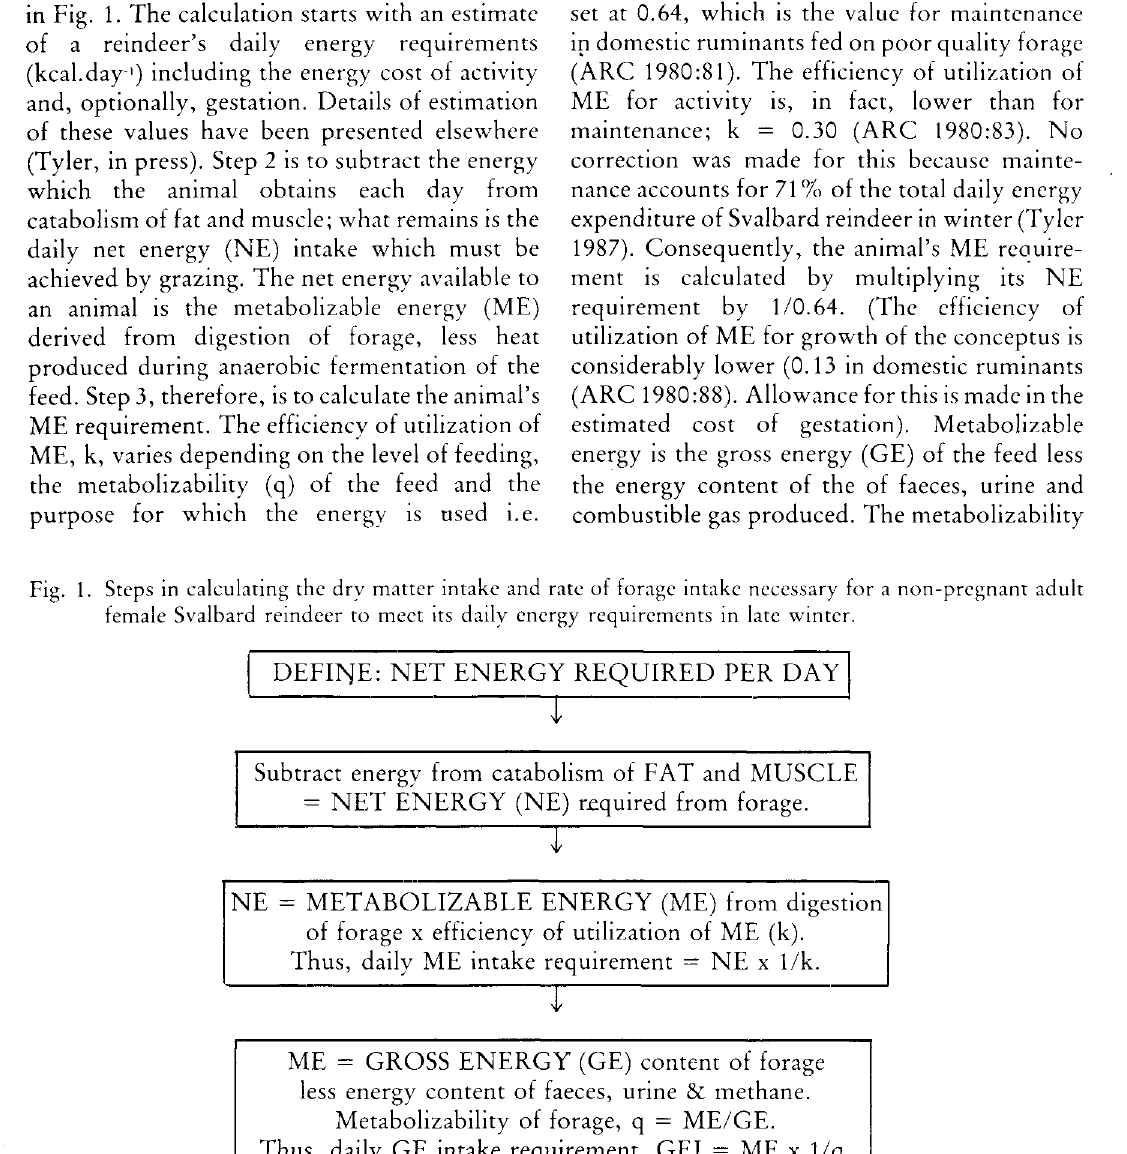
Fig. 1. Steps in calculating the dry matter intake and rate of forage intake necessary for a non-pregnant adult female Svalbard reindeer to meet its daily energy requirements in late